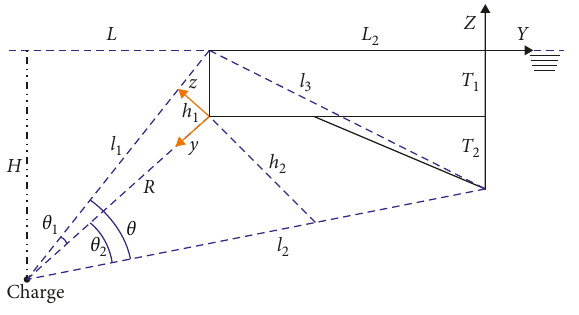
Figure 8: The condition at S